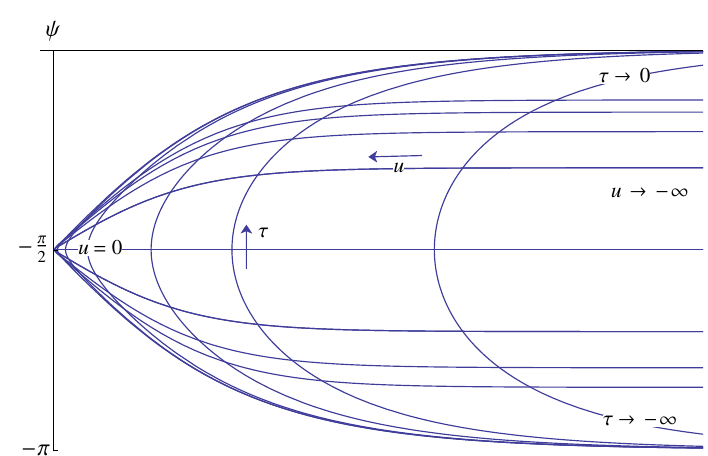
Figure 8. Embedding of the dS patch in global coordinates. The (cid:13)ow endpoint u = 0 corresponds to the point (cid:26) = 0 ;